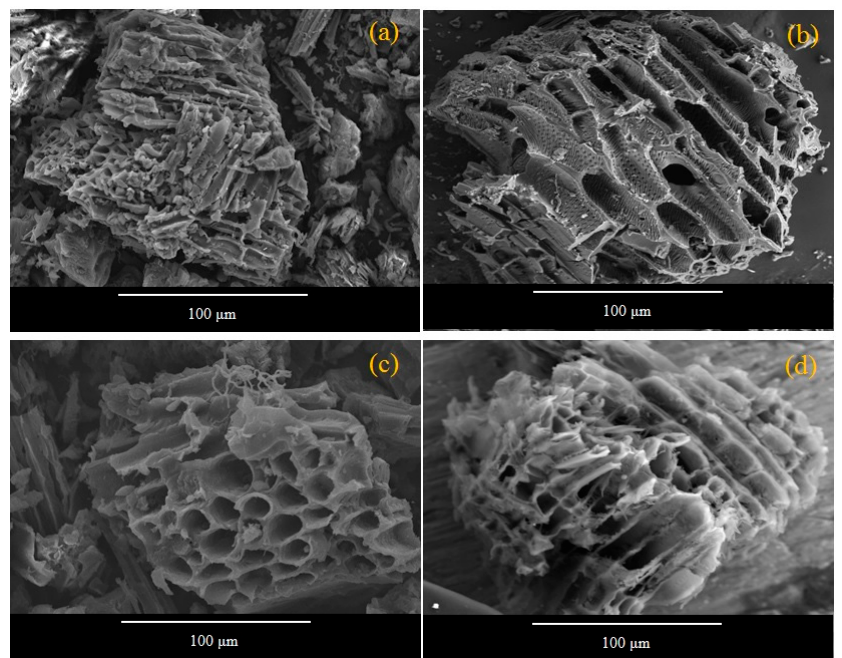
Figure 1. ( a , b ) SEM micro images of MA-AC400 adsorbent before RO16 adsorption; ( c , d ) after RO16 dye adsorption.